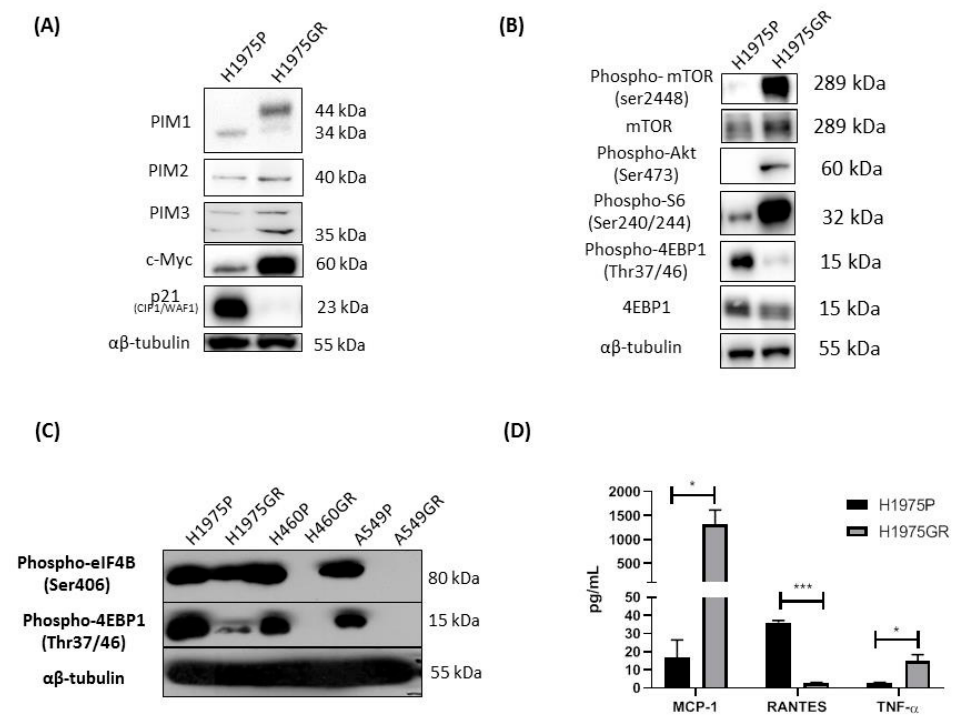
Figure 6. Protein evaluation of identified genes associated with PI3K/mTOR inhibitor resistance in the H1975GR cells. ( A ). Representative Western blot images showing significant upregulation of PIM1L ( p < 0.01), PIM2 ( p = 0.054), PIM3 ( p < 0.05), c-Myc ( p < 0.05), and downregulation of p21 (CIP1/WAF1) ( p < 0.05) in H1975GR compared to age matched parent H1975P cells. ( B ) Representative Western blot images showing alterations in PI3K/mTOR signaling between H1975P and H1975GR. H1975GR show upregulated p-mTOR ( p < 0.01), unaltered mTOR and upregulated p-AKT ( p < 0.01). H1975GR show hyperphosphorylated S6 ( p < 0.05), in contrast to decreased total 4EBP1 ( p = 0.0701) and hypo phosphorylated 4EBP1 (Thr37/46) ( p < 0.01). ( C ) p-4EBP1 (Thr37/46) showed a similar downregulation across all GDC-0980 resistant NSCLC cell line models and p-eIF4B (Ser406) was downregulated in H460GR and A549GR cells compared to the corresponding parent cell lines. ( D ) Conditioned media from H1975GR and H1975P cells were assayed using a magnetic bead based immunoassay (MILLIPLEX MAP), H1975GR secreted higher MCP-1 and TNF- α (both p < 0.05), and decreased RANTES ( p < 0.001) compared to H1975P. * p < 0.05, *** p < 0.001, paired student t -test, n ≥ 3. Original Western blots for Figure 6A–C in Figures